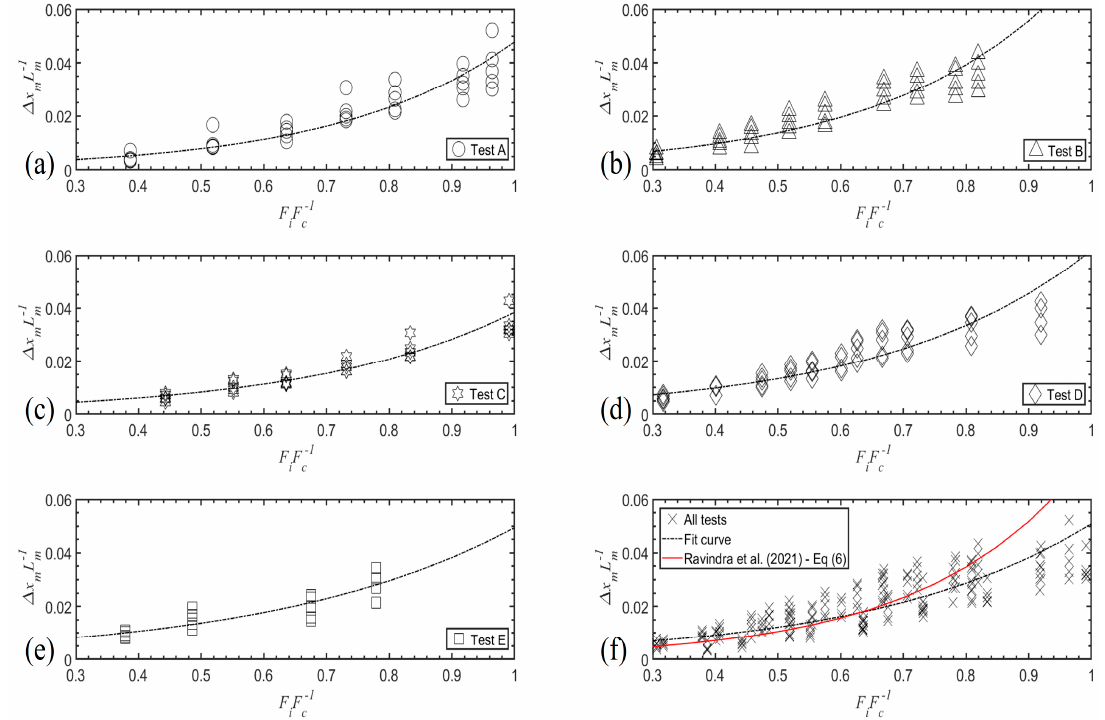
Figure 8. ( a – e ) Riprap marked stone displacement along x -axis according to normalized axial load values at the toe section for each of the five tests with exponential fitting curve representation. ( f ) Data for all tests put into perspective with the fitting curve from [20], in red, and the exponential fitting curve for all data, in dotted black line.